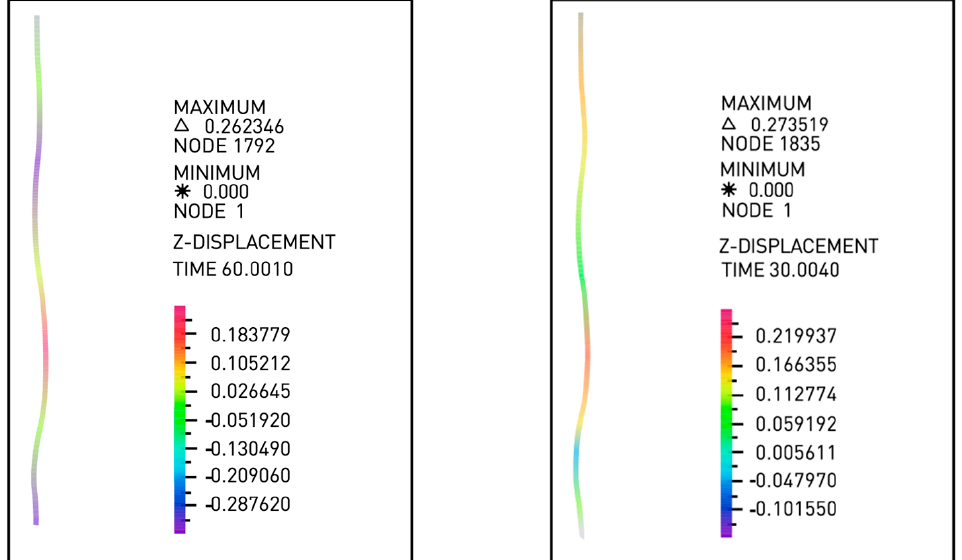
Figure 5. Checking calculation results of the experimental strings.